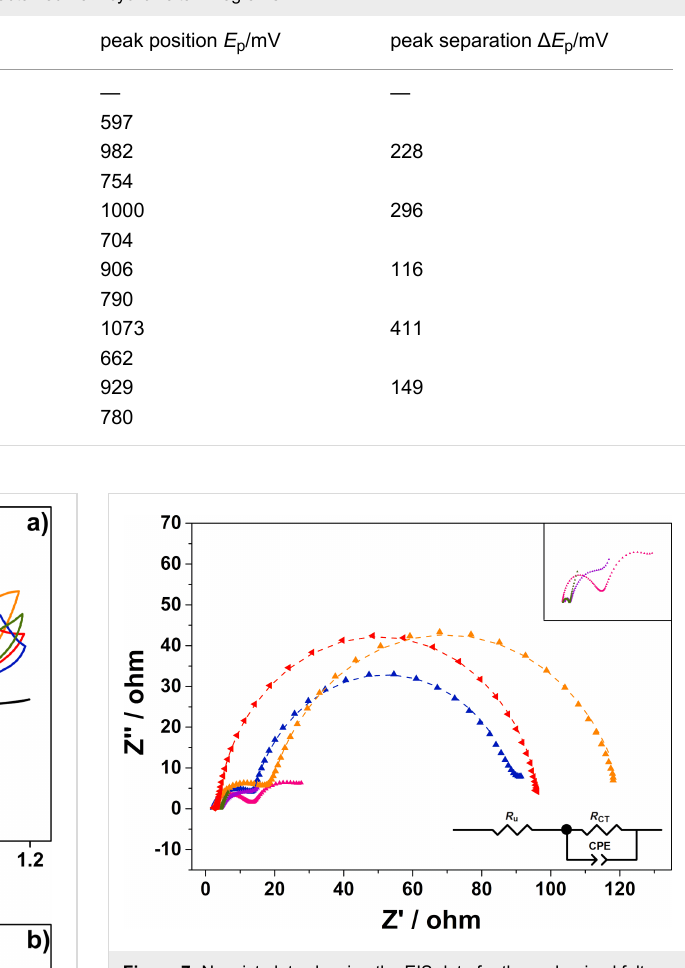
Figure 7: Nyquist plots showing the EIS data for the carbonized felts (orange, red) as well as for the composite electrodes heated up to 800 °C (pink, blue) and 1000 °C (purple, green) in the electrolyte solu- tion. The data were fitted to the circuit model displayed in the graph and the simulated curves are shown as dashed lines. In the inset, the data range from 0 to 30 Ω is enlarged to show details of the N-doped composite electrode (pink, purple) and the co-doped sample